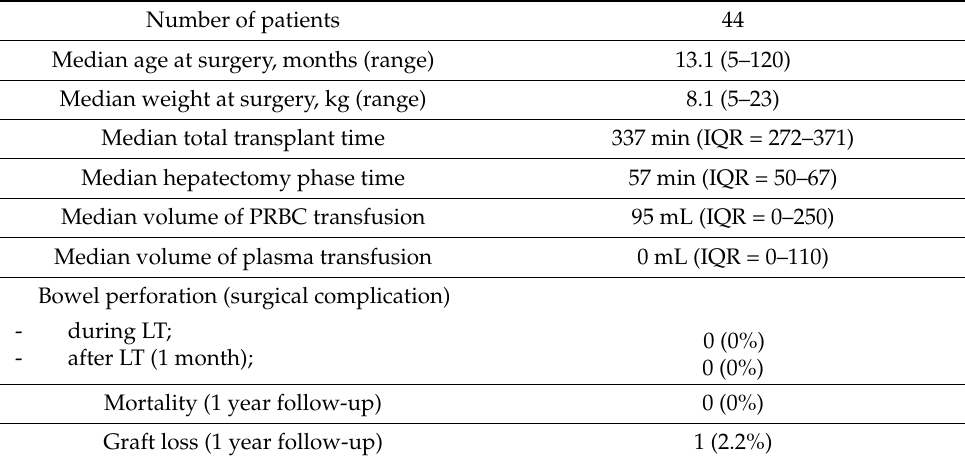
Table 1. Main outcomes of the series 1